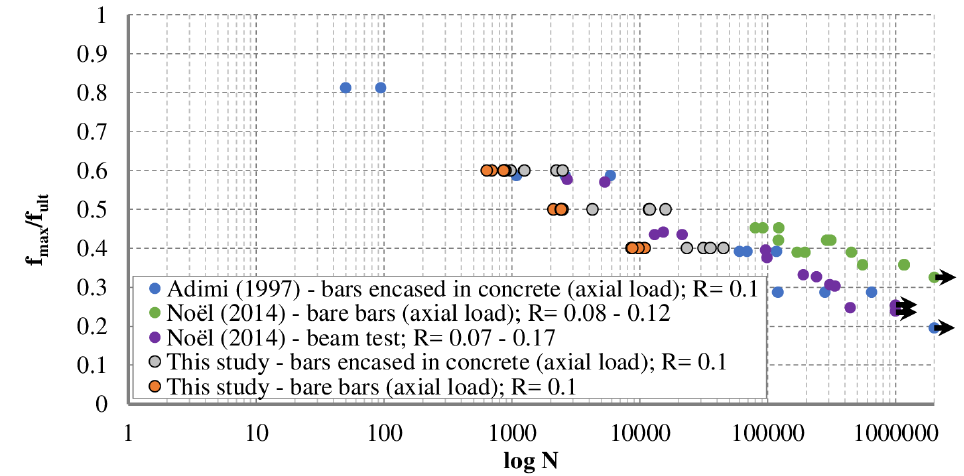
Figure 10. S-N diagram for GFRP